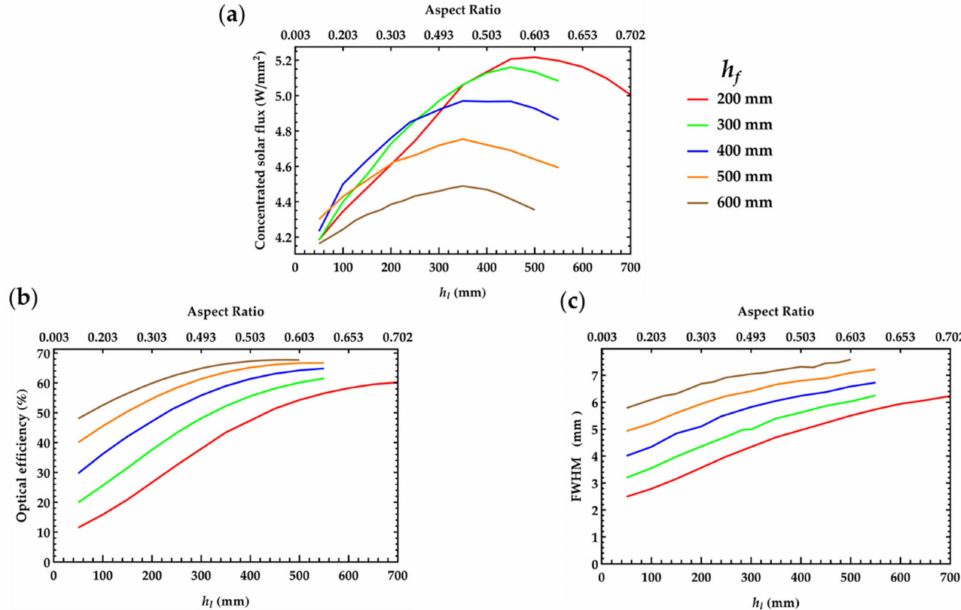
Figure 14. ( a ) Concentrated solar flux, ( b ) optical efficiency and ( c ) FWHM of the ESFL configurations with D = 1 m at various h f and h l